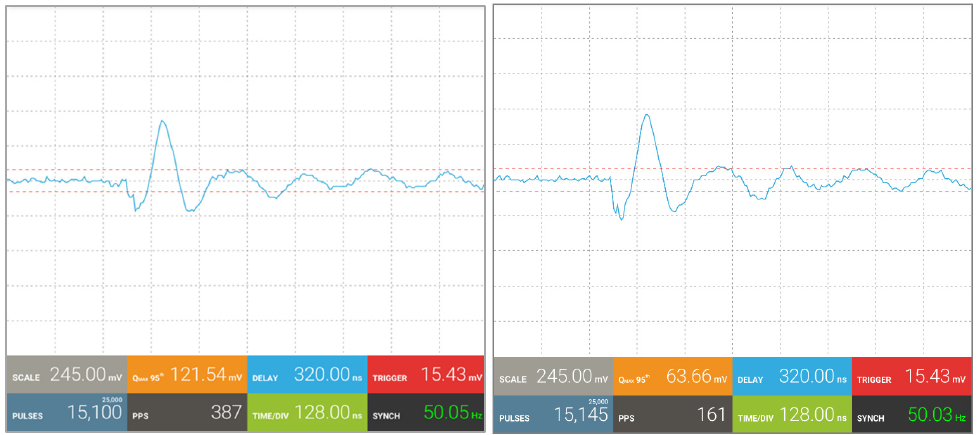
Figure 12. Typical time domain waveforms of internal time domain PD pulses detected by the Pry-cam sensor with the sinusoidal ( left ) and the DCP waveforms with δ = 0.6 ( right ).